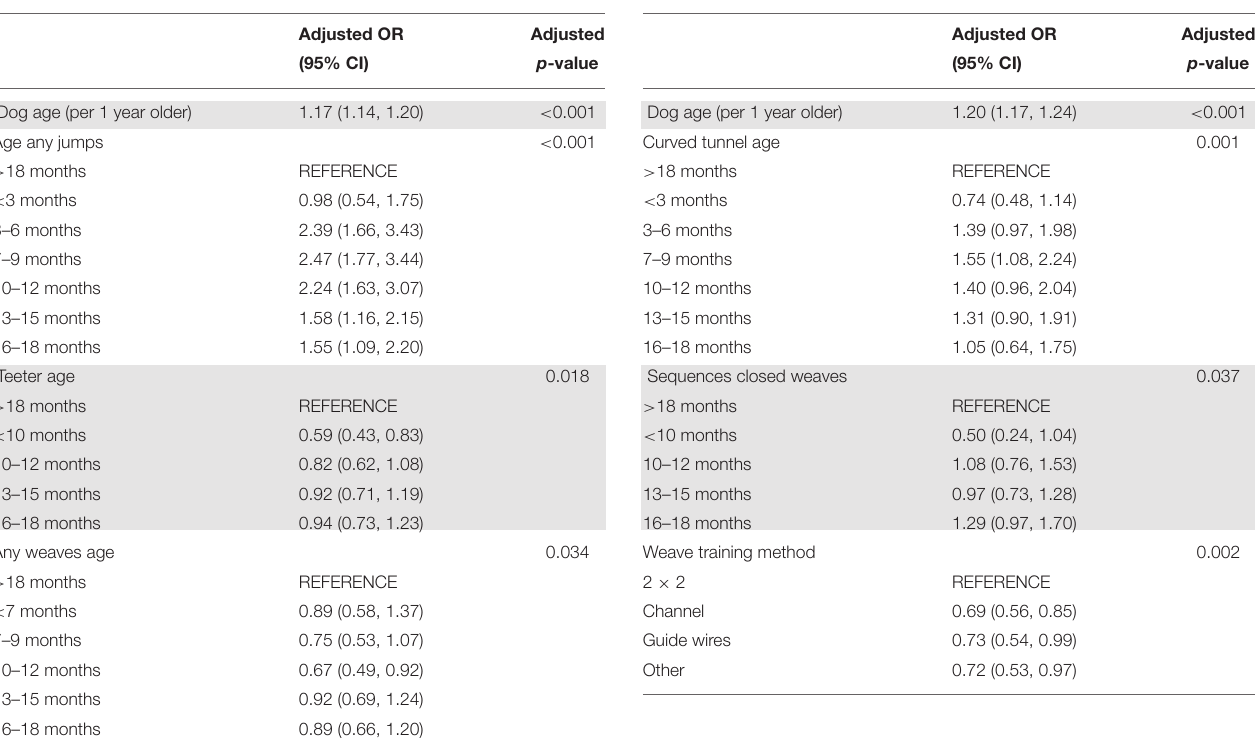
TABLE 6 | Coefficients from adjusted model with training level factors for severe